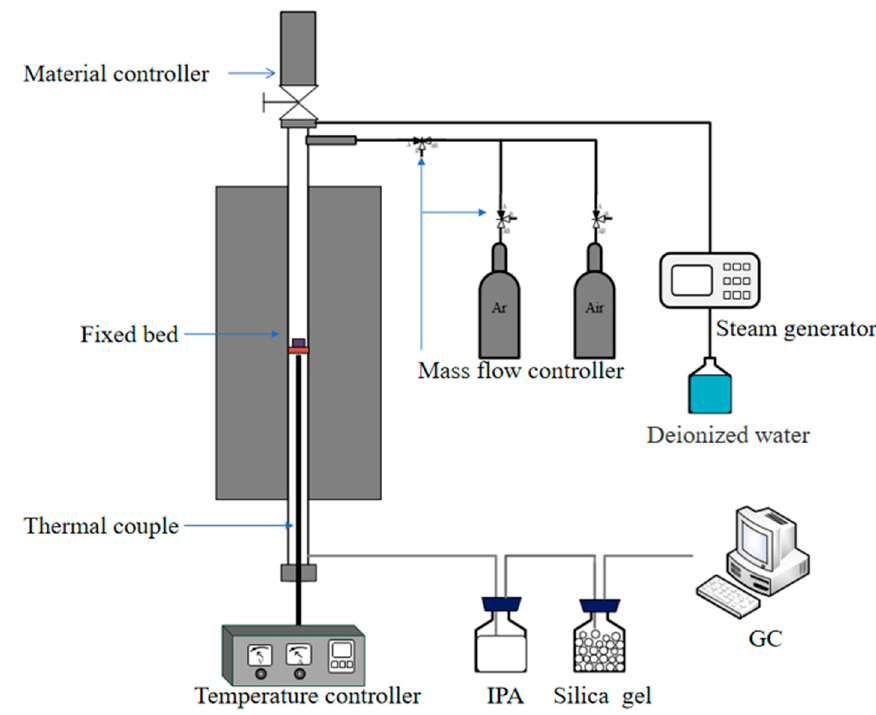
Figure 2. A schematic diagram of the experimental